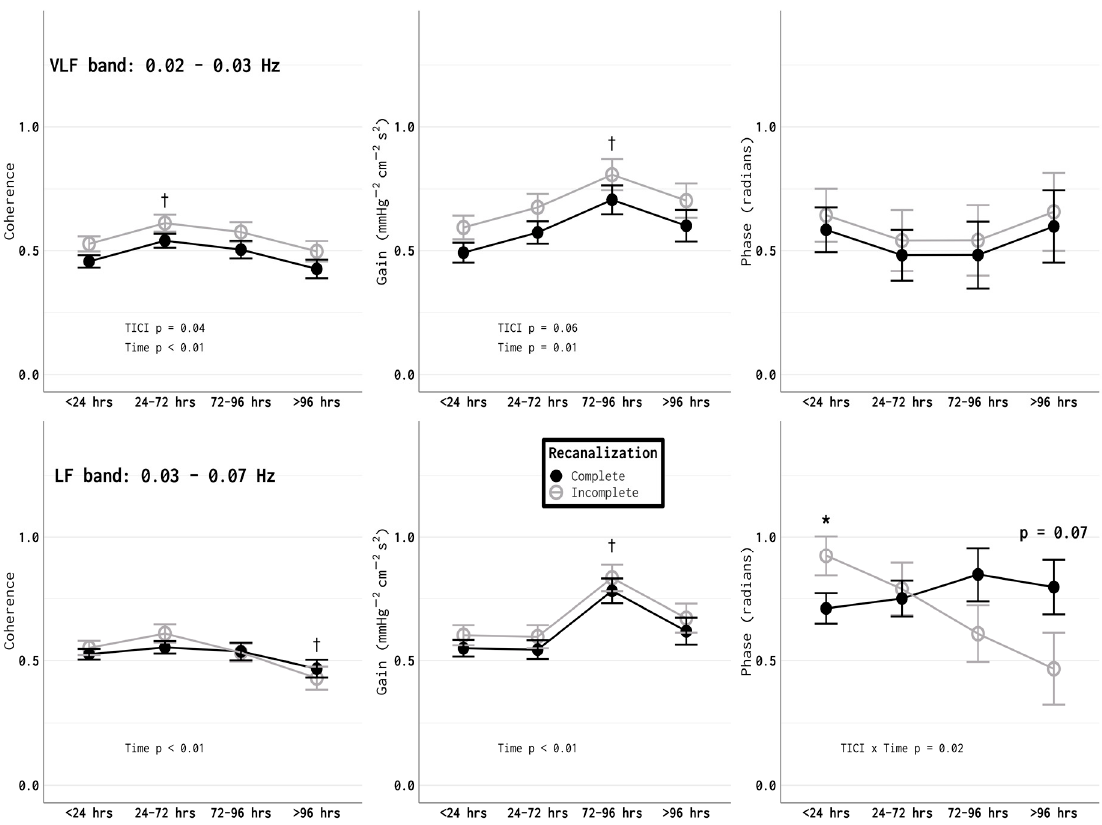
Figure 1. An improved TICI (Thrombolysis in Cerebral Infarction) scores in patients who received IAT (intra-arterial therapy) was associated with an improved autoregulation profile. In the VLF band, the coherence was higher in patients with an incomplete (TICI 2a or 2b) recanalization ( p = 0.04). In the LF band, there was a similar trend in the coherence, but this difference did not achieve statistical significance ( p = 0.07). The gain tended to be higher in patients with incomplete recanalization in the VLF band, but this difference did not reach statistical significance ( p = 0.06). For both the incomplete and complete recanalization groups, the gain peaked at the 72–96 h time point ( p = 0.01 for the VLF band, p < 0.01 for the LF band). No clear trends in the phase were observed in the VLF band. In the LF band, the phase increased over time in patients with complete recanalization and decreased over time in patients with incomplete recanalization ( p = 0.02). * p < 0.05, incomplete vs. complete recanalization, † p < 0.05 vs. < 24 h time